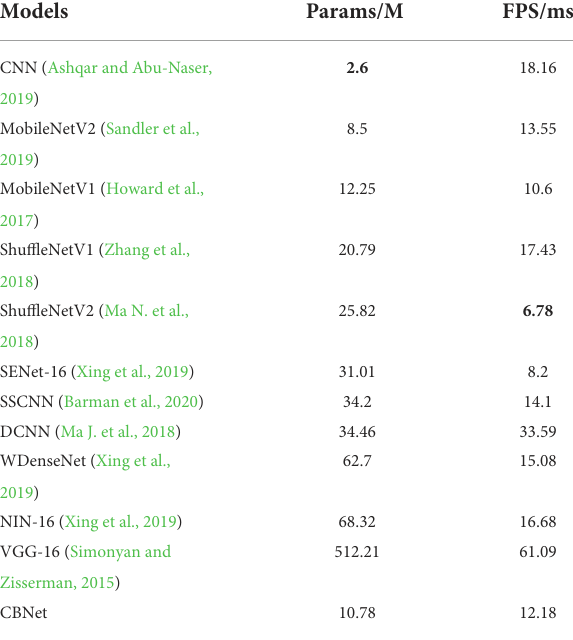
TABLE 2 Comparison of the classification results of our model and other models (bold represents the model with the best